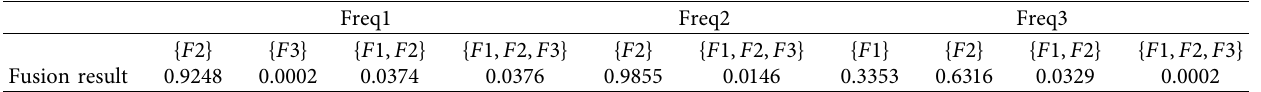
Table 9: Sensor data fusion results for fault diagnosis.